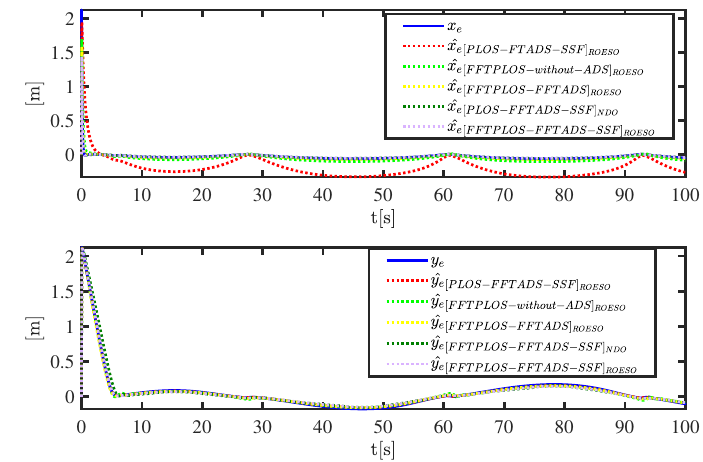
Figure 6. The position errors and its estimations with predictors.